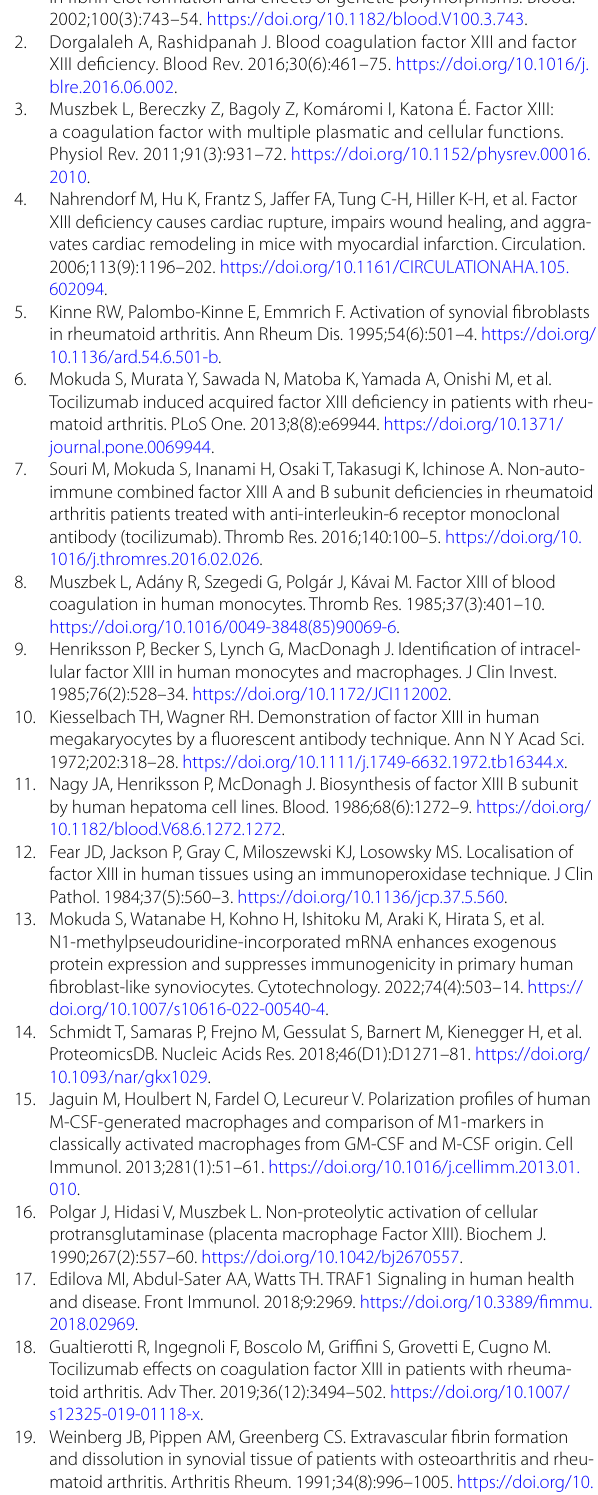
(red) antibodies. Black scale bar 100 μm. Supple. Fig. 6. Fluorescent IHC = staining for FXIII-B & CDH11. Supplementary images for Fig. 3. Images of fluorescence staining with each antibody and low power field images. Black scale bar 100 μm. Supple. Fig. 7A. Alteration of FXIII-B expres- = sion levels in passage culture of FLS. The expression levels of F13B in synovial fibroblasts were measured using RT-qPCR. ( n 3; mean SEM). = ± Supple. Fig. 7B. F13B expression in FLS is not altered by IL-6 stimulation. The expression levels of F13B in synovial fibroblasts with or without IL-6 and sIL-6Rα were measured using RT-qPCR. ( n 3; mean SEM). Supple. = ± Fig. 8. The schema of macrophage generation. The schema of monocyte- derived macrophage generation created using BioRe nder. com. Supple. Fig. 9. Knockdown of STAT1 using siRNA. The expression level of